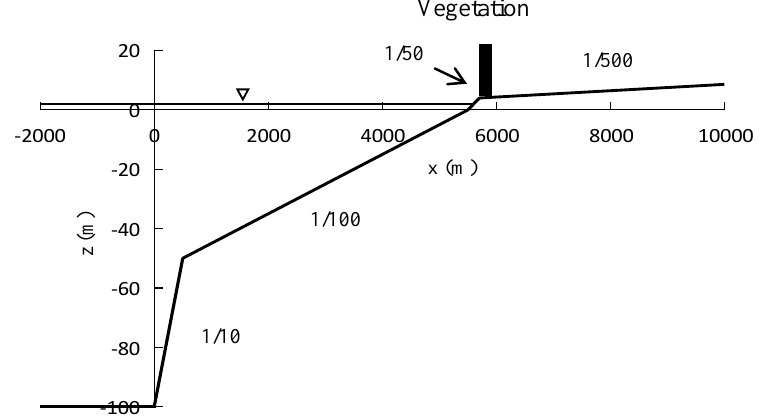
Figure 9. Schematic topography of a tsunami flume with vegetation effects.